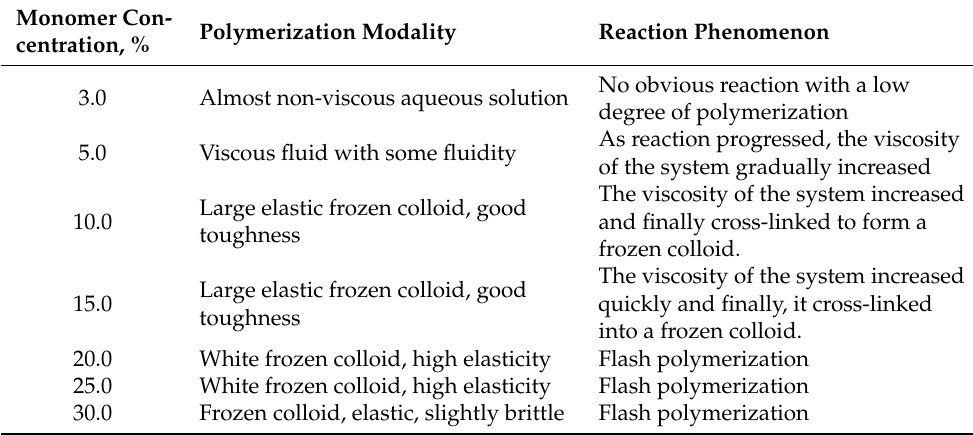
Table 2. Reaction phenomena under different amounts of polymerization monomers.